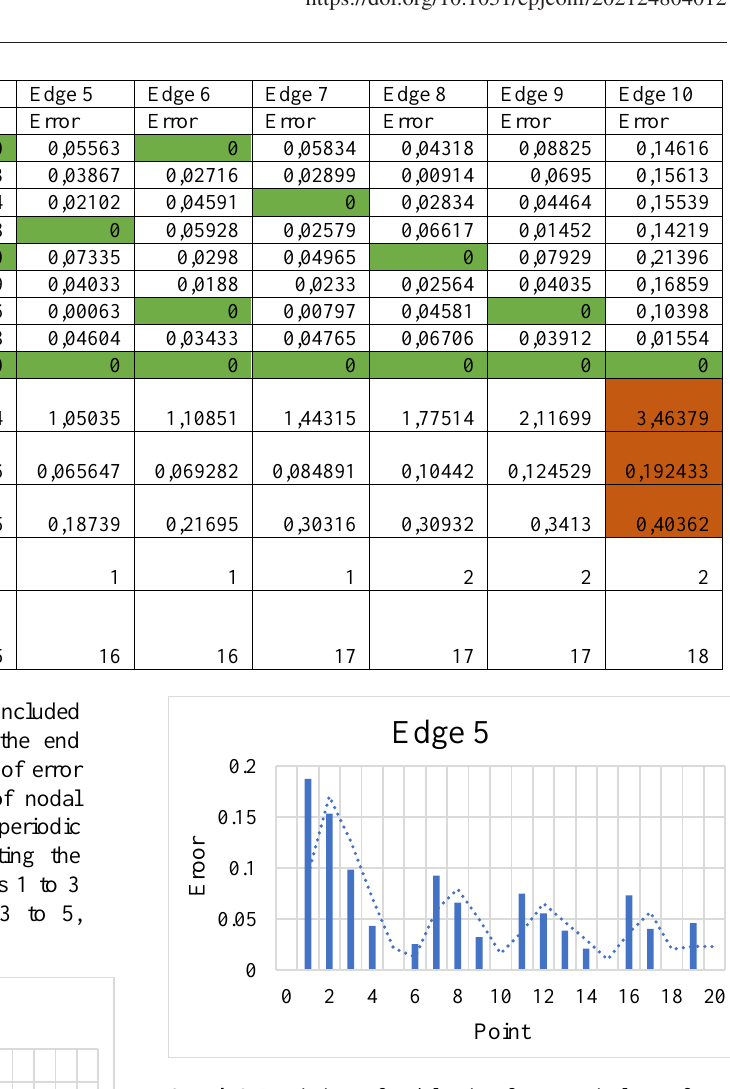
Graph 3. Deviations of nodal points from nominal ones for result